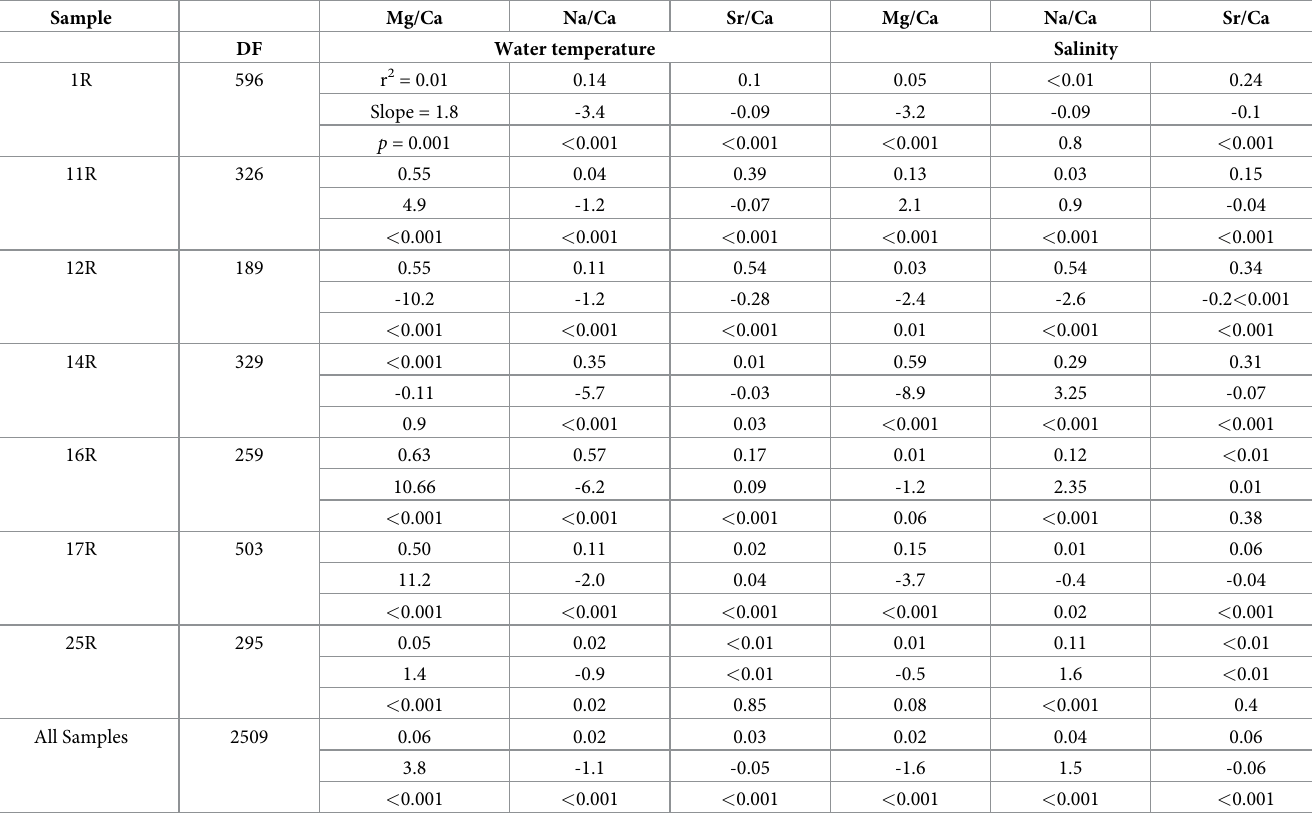
Table 4. Coefficients of determination r 2 , slope and p -values of temperature and salinity with the investigated elemental ratios.